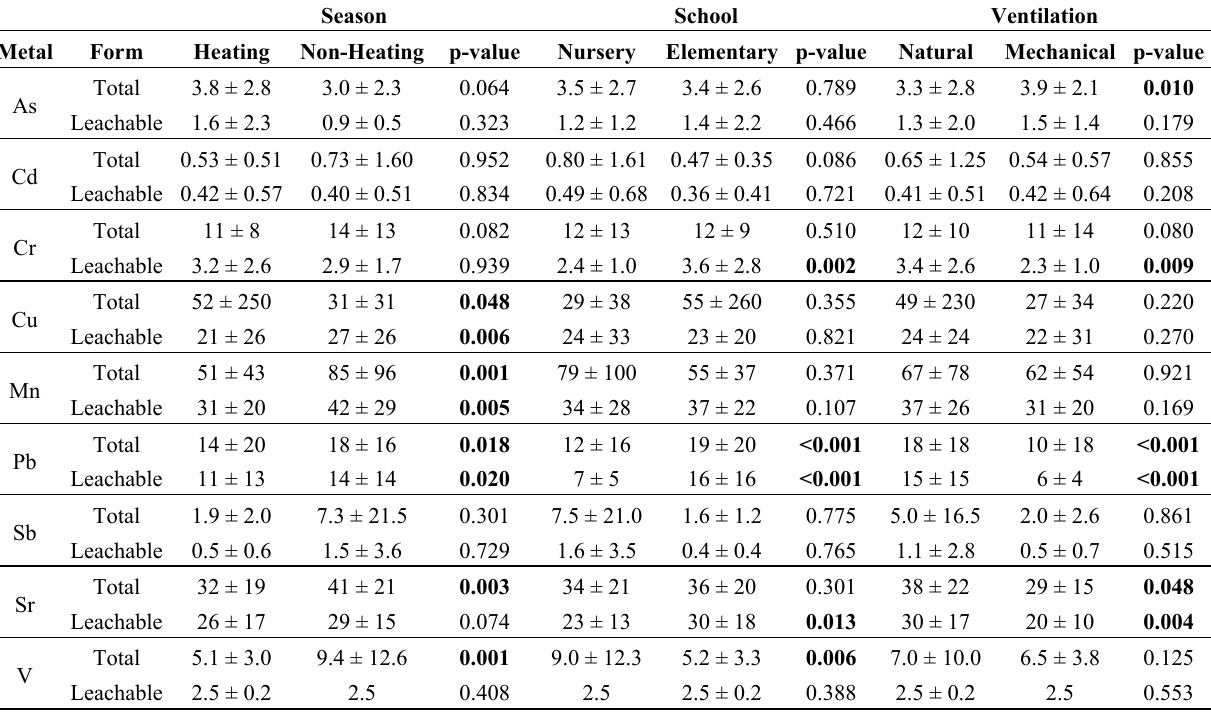
settled dust samples from the 51 classrooms by sampling season, school type and ventilation type. Bold values denote significant p -values (Mann-Whitney